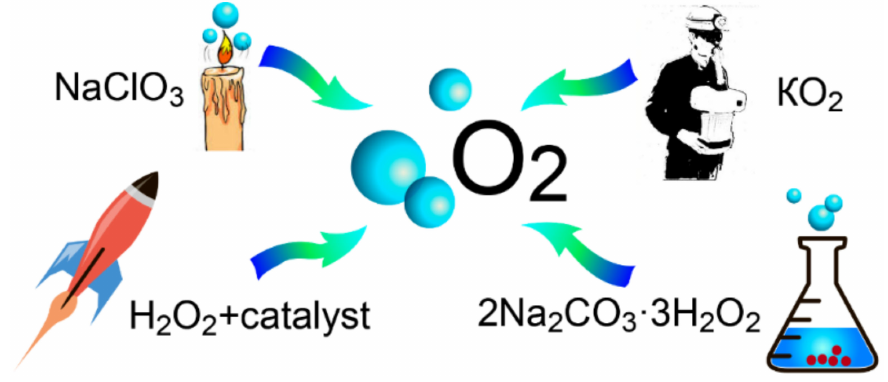
Figure 2. Oxygen production from storage materials via chemical